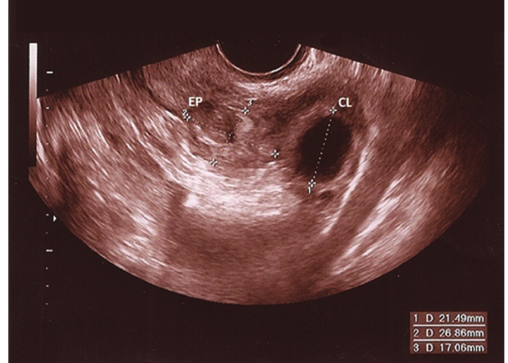
Figure 1: Transvaginal gray-scale US image of left adnexa reveals a 25 mm hyperechoic mass with a central hypoechoic shadow, suggestive of a tubal pregnancy. ES: ectopic sac; CL: corpus luteum.